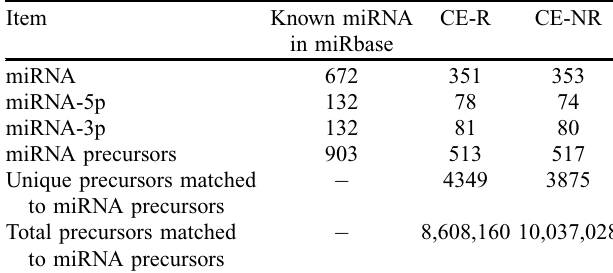
Table 2. Summary of known miRNAs in each